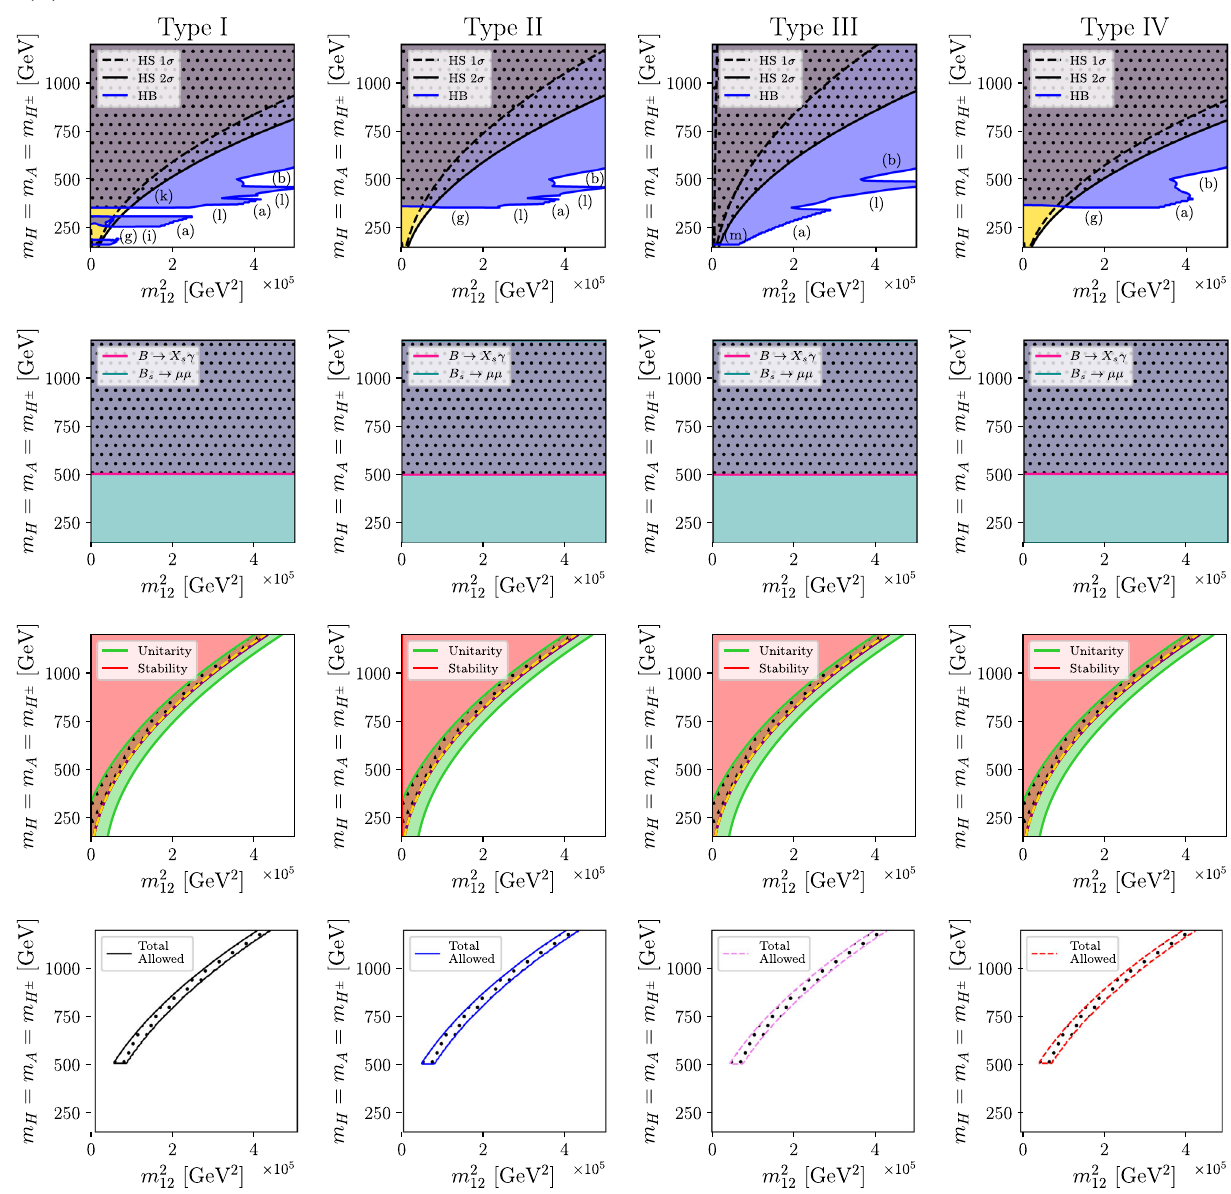
Fig. 3 A Allowed regions from the restrictions on the parameter space in benchmark scenario 3 in the m 2 c β − α = 0 . 01.TheresultsfortypeI,II,IIIandIVintheleft,second,third andrightcolumn,respectively.Theupper,secondandthirdrowshowthe restrictionsfrom HiggsBounds / HiggsSignals ,theflavorobserv- ables and from unitarity/stability, respectively. The fourth row indicates theregionsallowedbyallconstraintsintherespectivescenario. B Triple